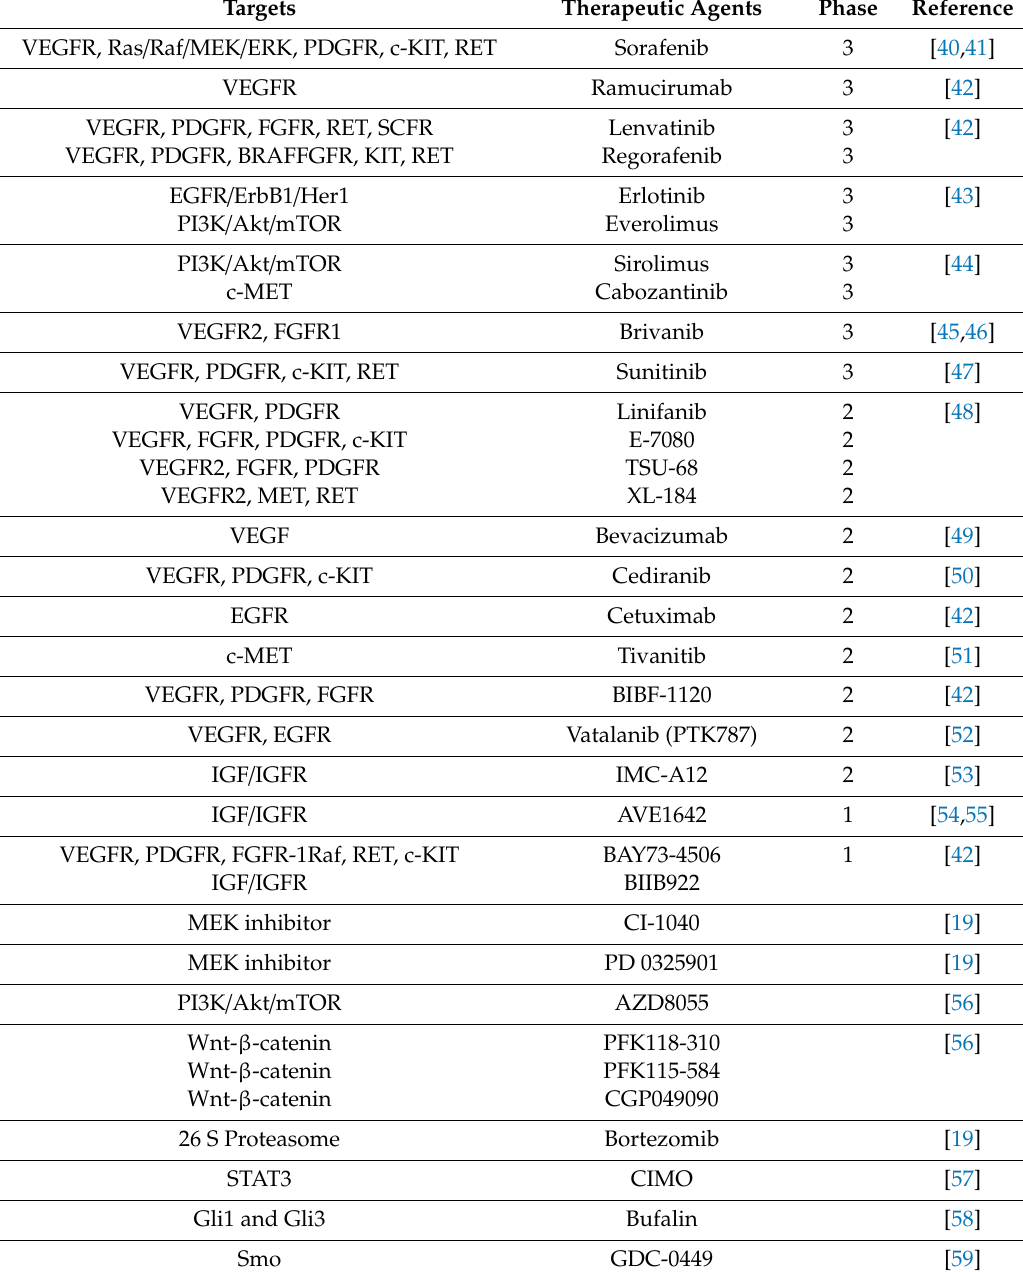
Table 1. List of Molecular Targets and potential therapeutic agents used against